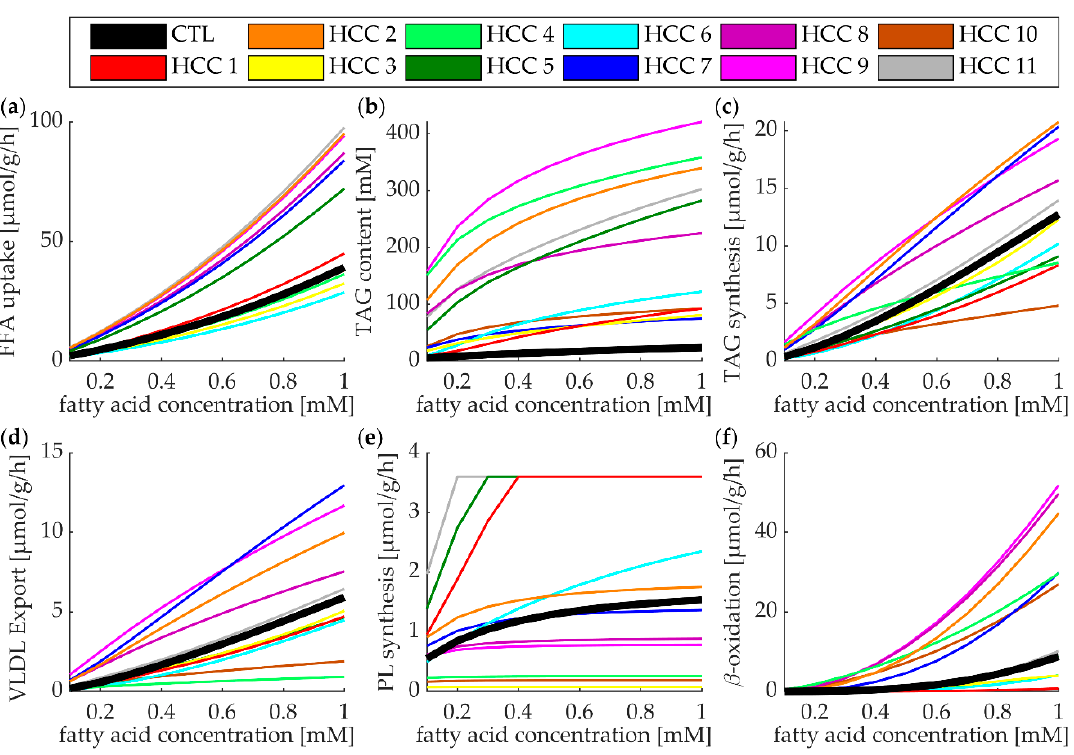
Figure 4. Metabolic response of HCCs and control to increasing external concentrations of FFAs. Color assignment to tumors and control is the same as in Figure 3. ( a ) Free fatty acid (FFA) uptake, ( b ) intracellular TAG content, ( c ) TAG synthesis rate, ( d ) VLDL export rate, ( e ) phospholipid (PL) synthesis rate, ( f ) rate of β -oxidation (i.e., activity of CPT1).